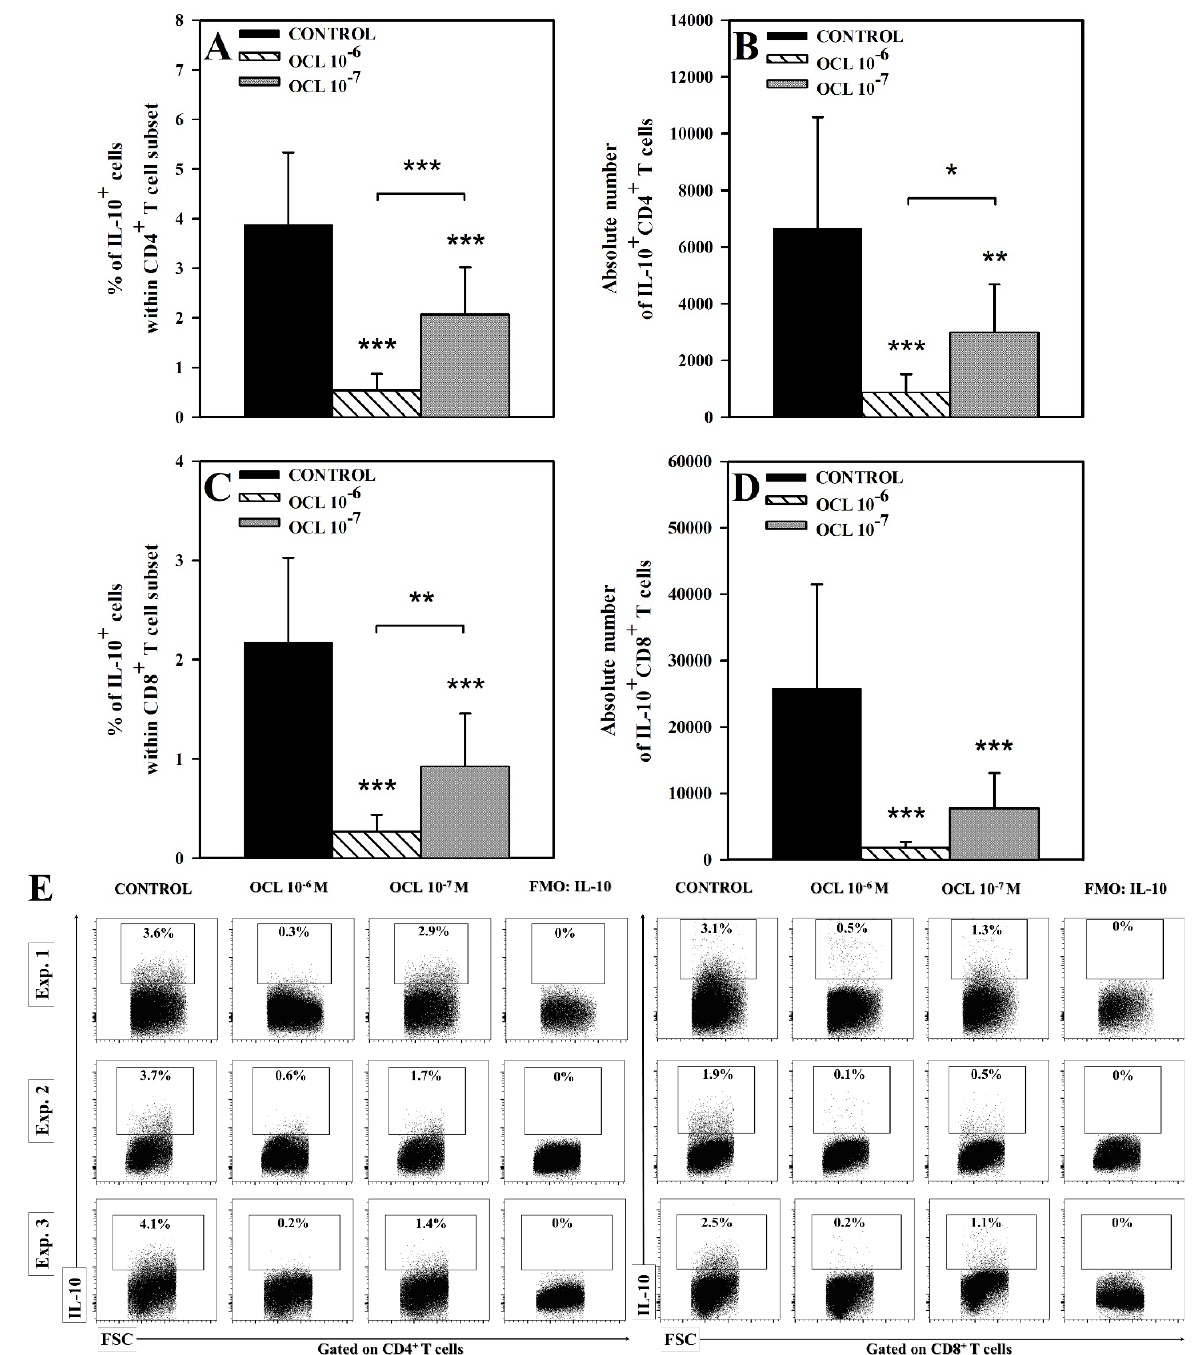
Figure 4. Effect of oclacitinib (OCL) on the number of IL-10-producing CD4 + and CD8 + T cells. The relative ( A , C ) and absolute count ( B , D ) of IL-10-producing CD4 + and CD8 + T cells were determined in cell cultures incubated with or without (control) OCL (10 − 6 M and 10 − 7 M). The relative count is expressed as a percentage of IL-10-producing cells within CD4 + and CD8 + T cells. The absolute count represents the number of IL-10 + CD4 + and IL-10 + CD8 + T cells per sample well. Results are expressed as the mean (± S.D.) of three independent experiments with 5 mice per experiment (overall n = 15, * p < 0.05, ** p < 0.01, *** p < 0.001, control cells vs OCL-treated (10 − 6 or 10 − 7 M) cells (Student's unpaired t-test), or OCL 10 − 6 -treated vs OCL-10 − 7 -treated cells (one way ANOVA with Holm-Sidak multiple comparison test)). Examples of dot plot cytograms show the distribution of IL-10-producing and non-producing cells within CD4 + and CD8 + T cell subset ( E ). Fluorescence minus one (FMO) controls were applied to confirm the gating strategy used to identify IL-10 + cells.